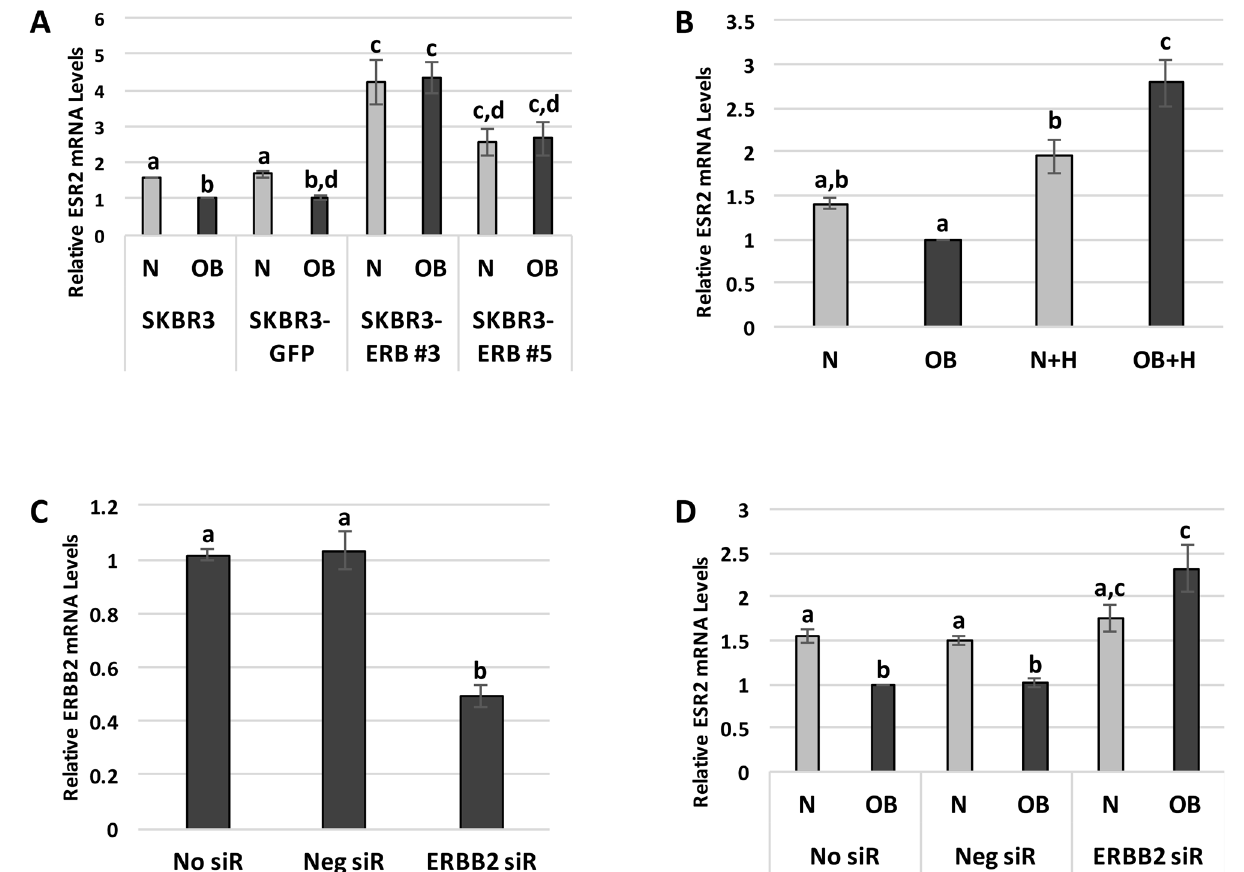
Fig 3. Obesity-associated systemic factors inhibit ESR2 gene transcription via HER2 signaling. (A) ESR2 mRNA levels in parental SKBR3 cells and SKBR3 cells stably transfected with an empty pGFP vector (SKBR3-GFP) or a GFP-tagged ESR2 overexpression plasmid (SKBR3-ERB#3 and #5). Quantitative RT-PCR was used to assess ESR2 mRNA levels following exposure to normal weight (N) or obese (OB) patient sera for 1 hour. (B) ESR2 mRNA levels, measured by quantitative RT-PCR, in SKBR3 cells exposed to N or OB patient sera for 1 hour +/- 1.0 ug/ml Herceptin (H). (C) ERBB2 expression, measured by quantitative RT-PCR, in SKBR3 cells without transfection (No siR) or following transfection with negative control siRNA (Neg siR) or siRNA to ERBB2 (ERBB2 siR). (D) ESR2 expression, measured by quantitative RT-PCR, after a 1-hour exposure to OB or N patient sera, in SKBR3 cells transfected with No siR, Neg siR, or ERBB2 siR. Data shown represents the average of at least three independent experiments. Different letters indicate statistically significant differences, p <